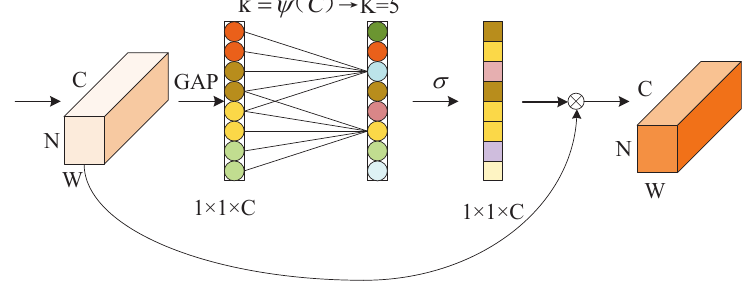
Figure 4. The ECA